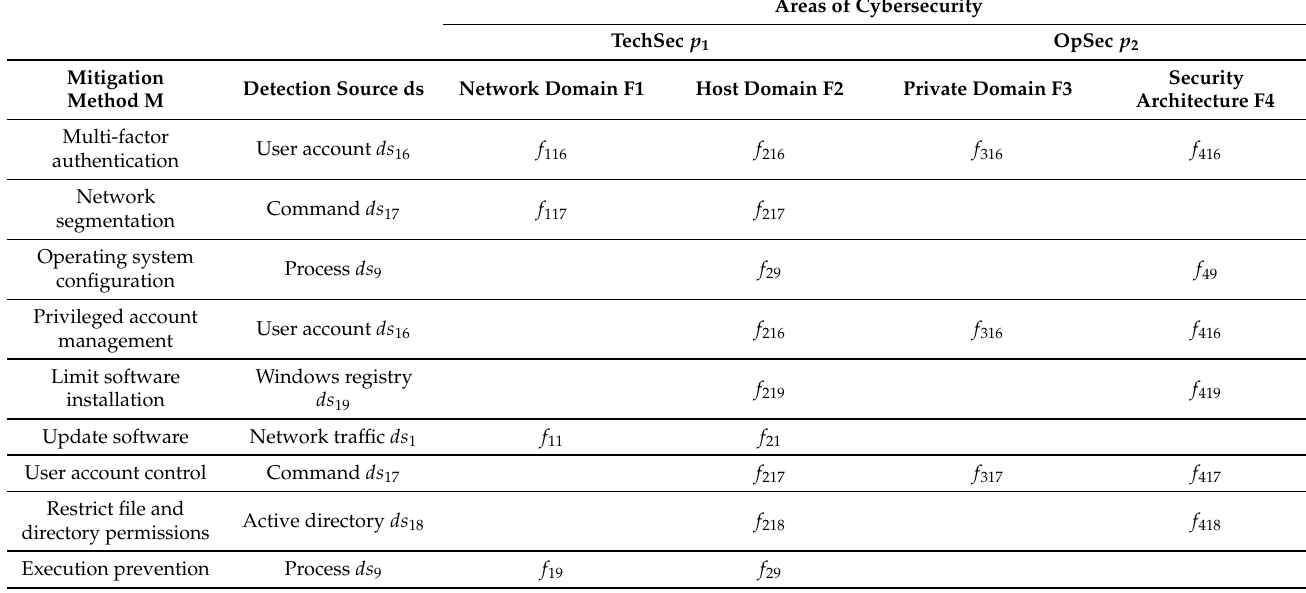
Table 5. Stage 5: